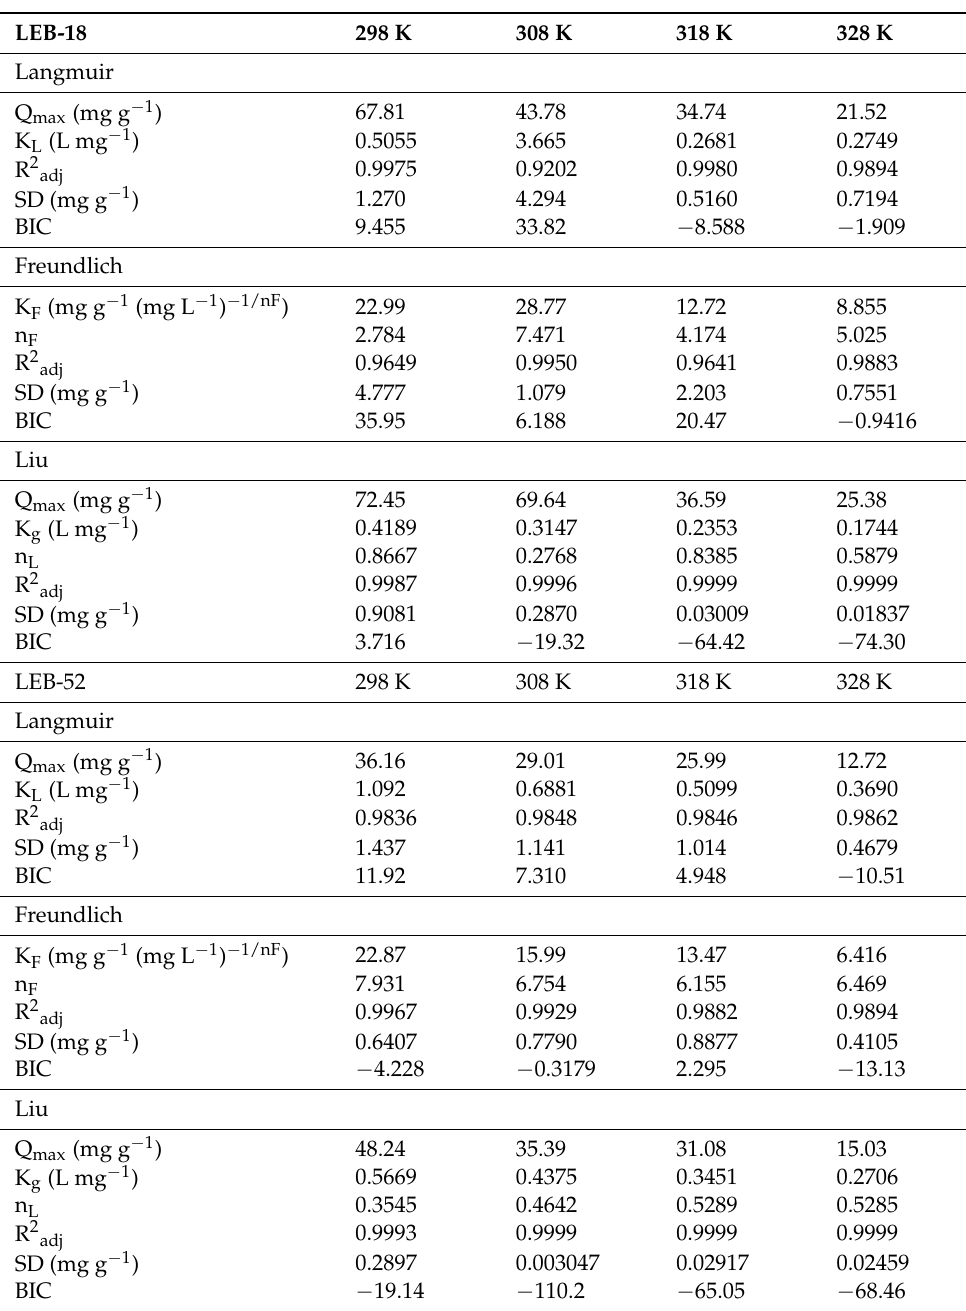
Table 4. Biosorption parameters isotherm models for removing Nd(III) onto LEB-18 and LEB-52 Spirulina platensis